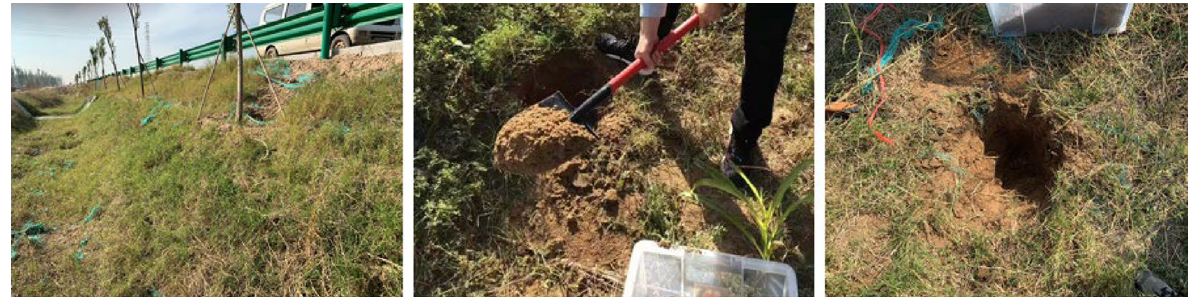
Figure 1. Raw soil extraction process.